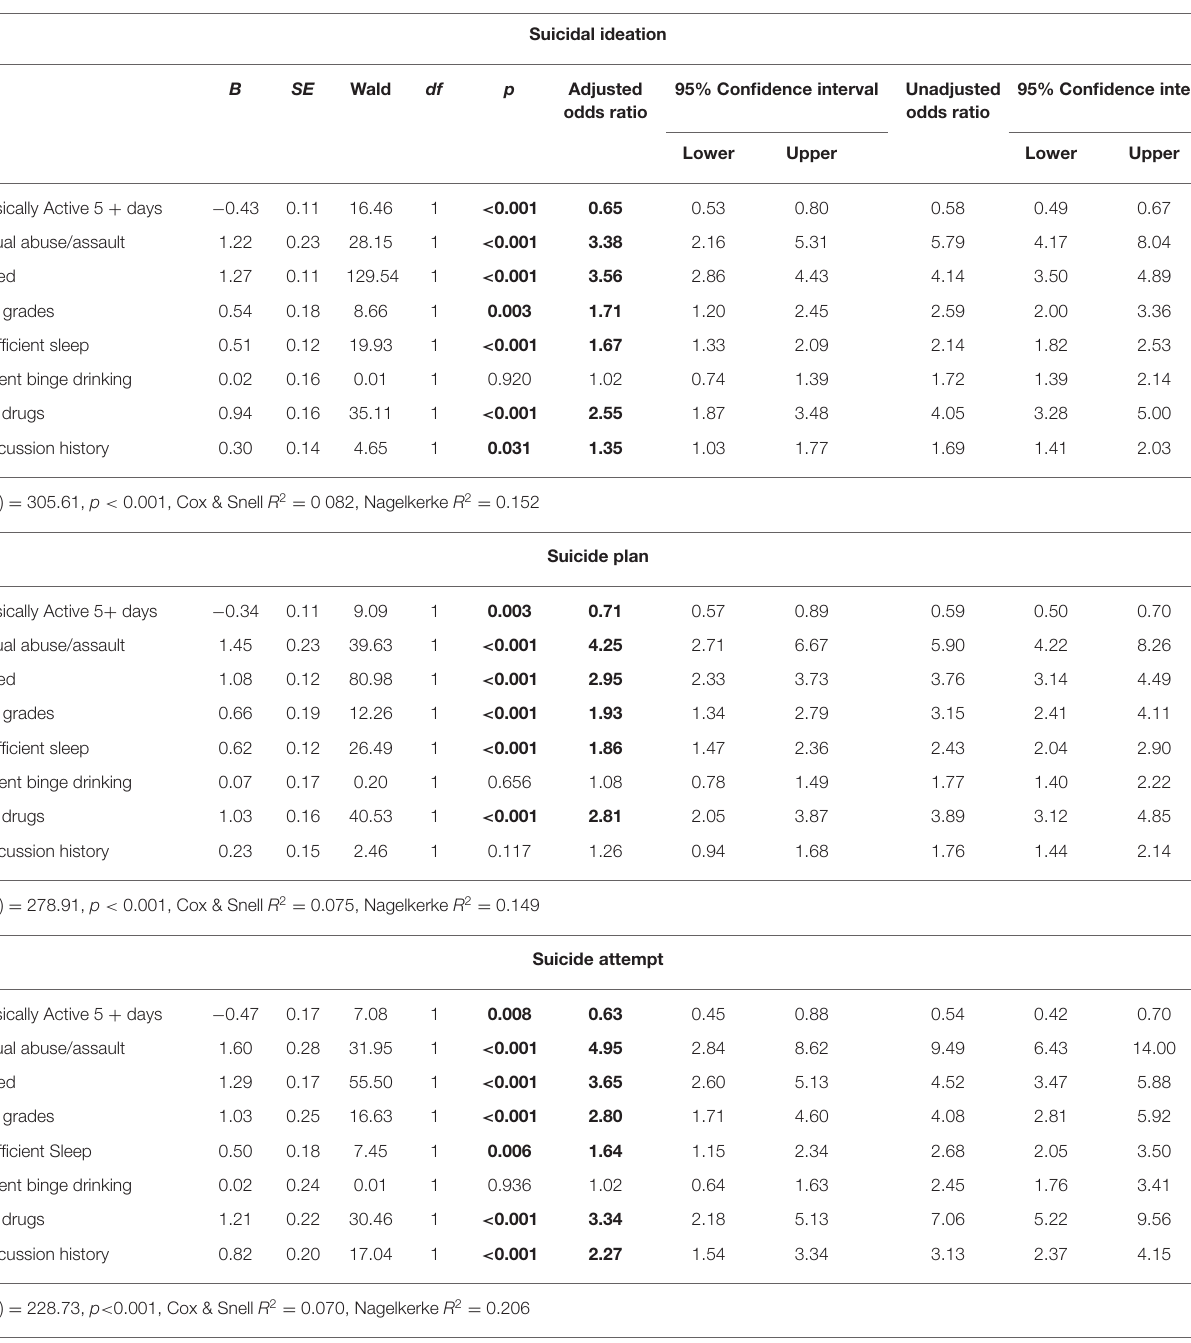
TABLE 6 | Logistic regressions predicting suicidality in boys (reduced set of